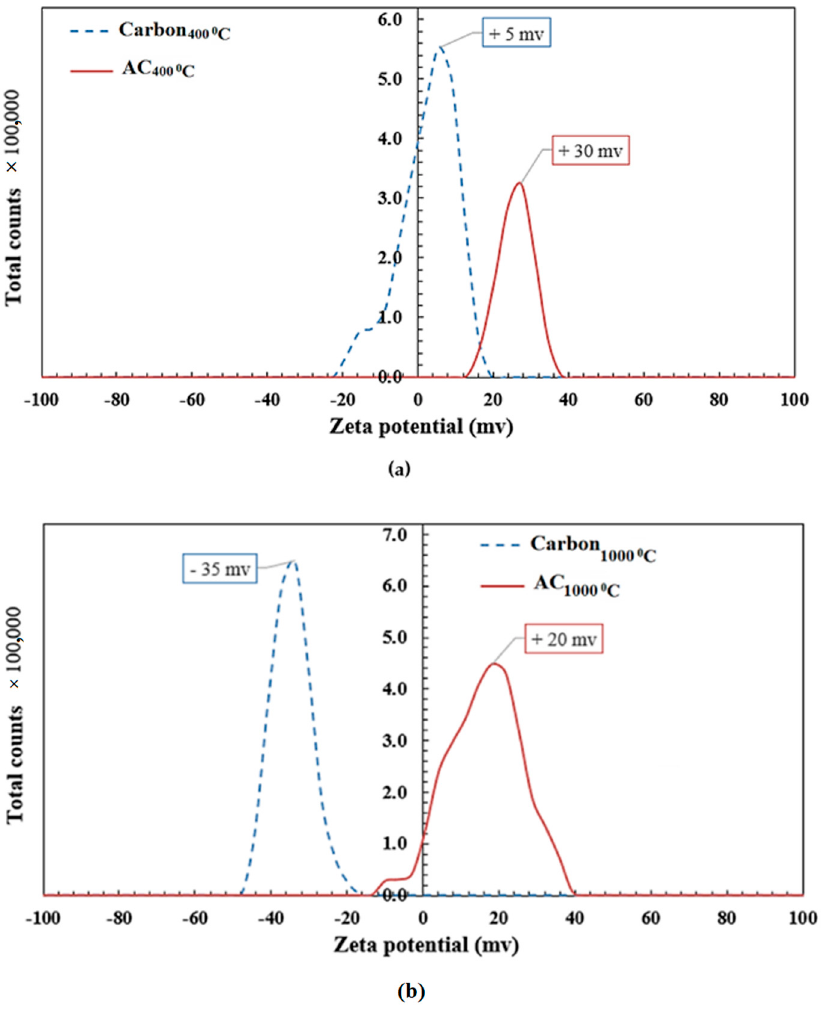
Figure 4. Effect of activation process on carbon surface charge of ( a ) carbon at 400 °C and ( b ) carbon at 1000 °C.